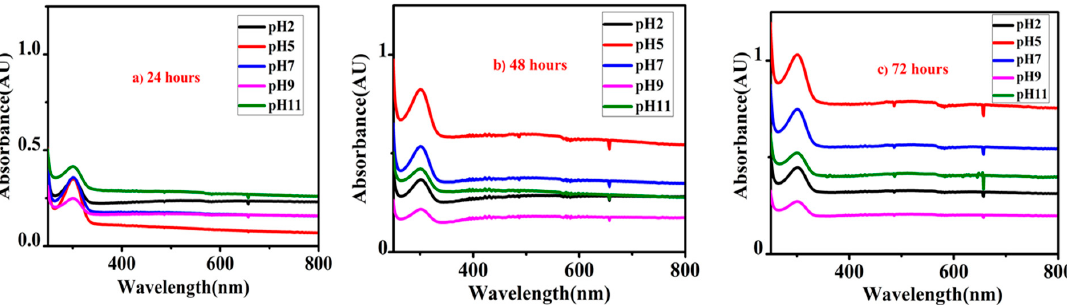
Figure 9. UV-Vis spectra of HNTs loaded with inhibitor immersed in 0.1M NaCl solution at various pH levels for different immersion time intervals, ( a ) 24 h, ( b ) 48 h, and ( c ) 72 h.